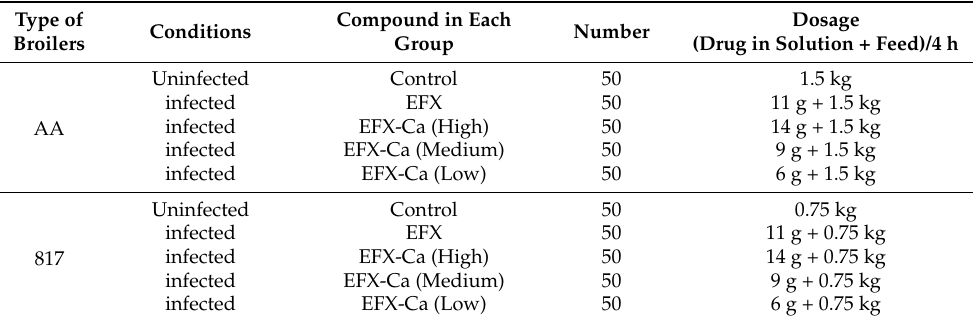
Table 9. Conditions for the drug-mixed feeding on two types of tested broilers.